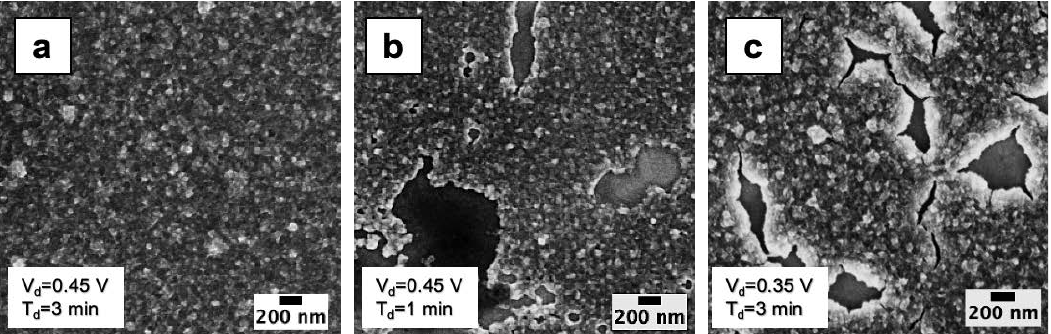
Figure 7. High resolution SEM images of the samples deposited by applying ( a ) 0.45 V for 3 min, ( b ) 0.45 V for 1 min and ( c ) 0.35 V for 3 min.